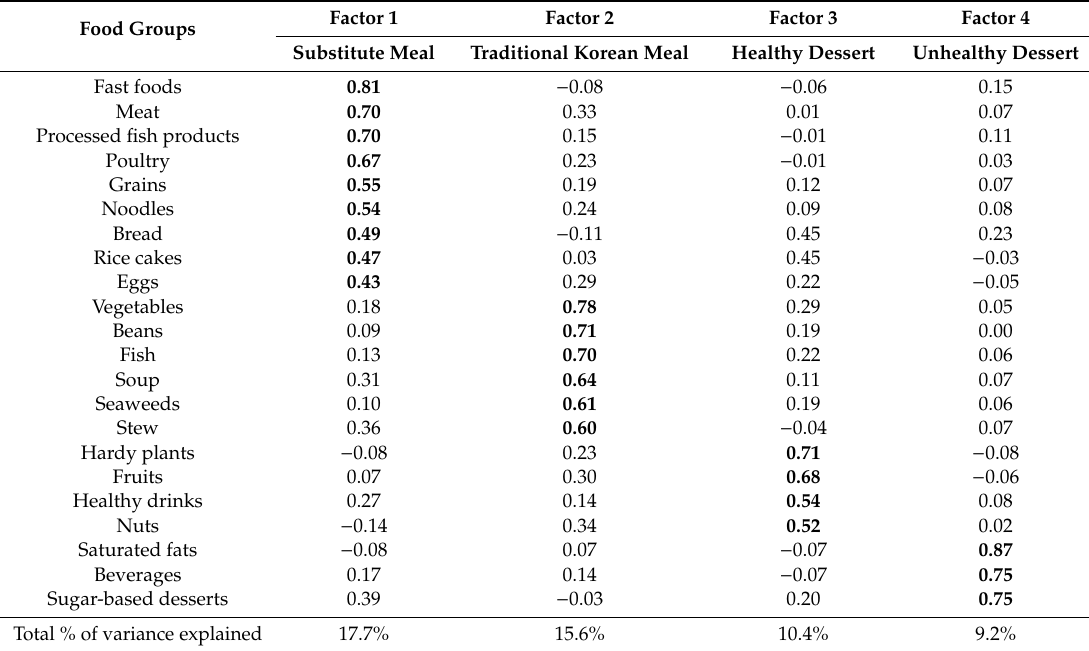
Table 2. Factor loading matrix for the four major dietary types ( n =